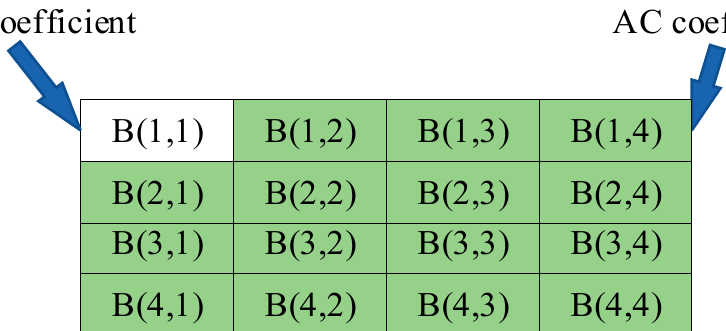
Figure 5. 4 × 4-pixel block DCT coefficient distribution.